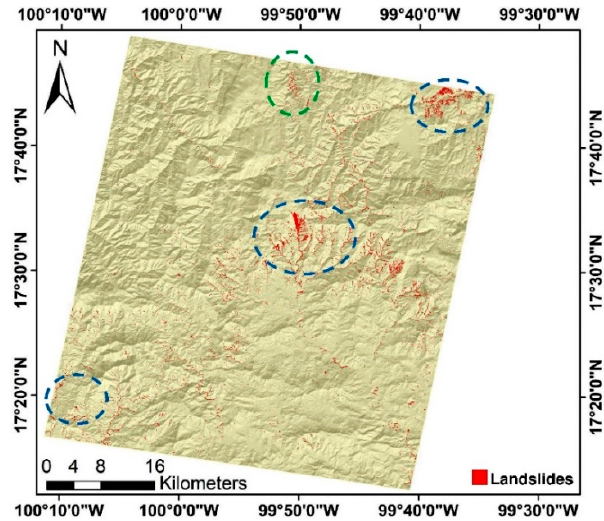
Figure 13. Final landslide inventory map. The blue highlighted areas are where photointerpretation and digitization was completed. The green highlighted are zones where no-photointerpretation or digitization work was carried